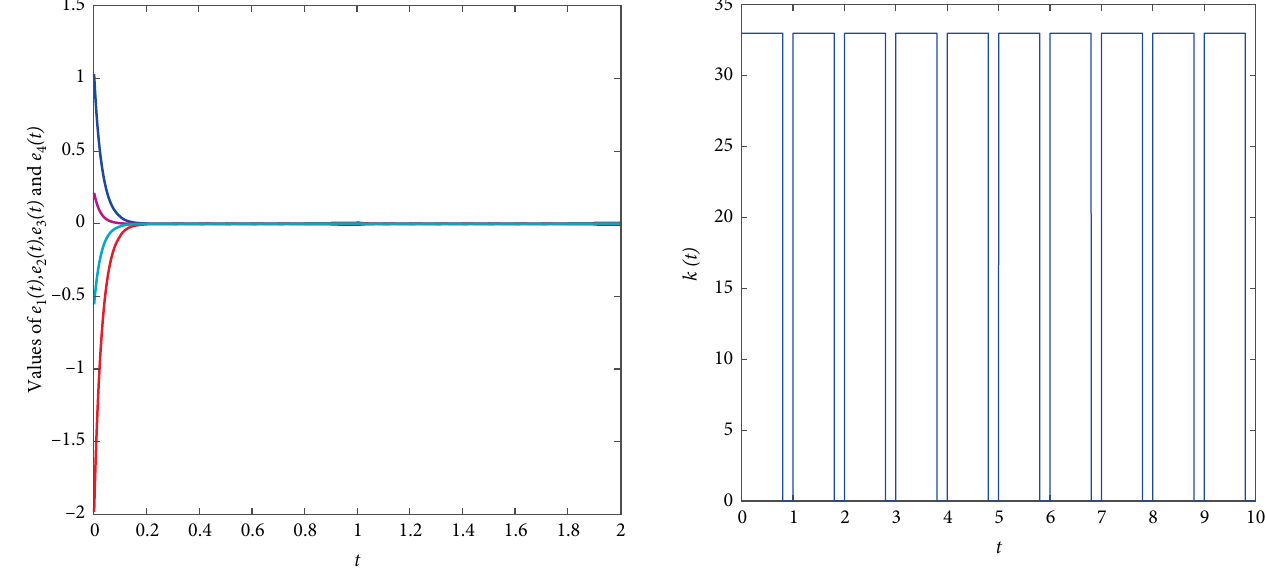
Figure 6: Time evolution of intermittent feedback control gain for error system (16) with periodic intermittent controller (15), where , , 𝜎 = 0.8 𝛼 = 0.985 𝑇 = 1